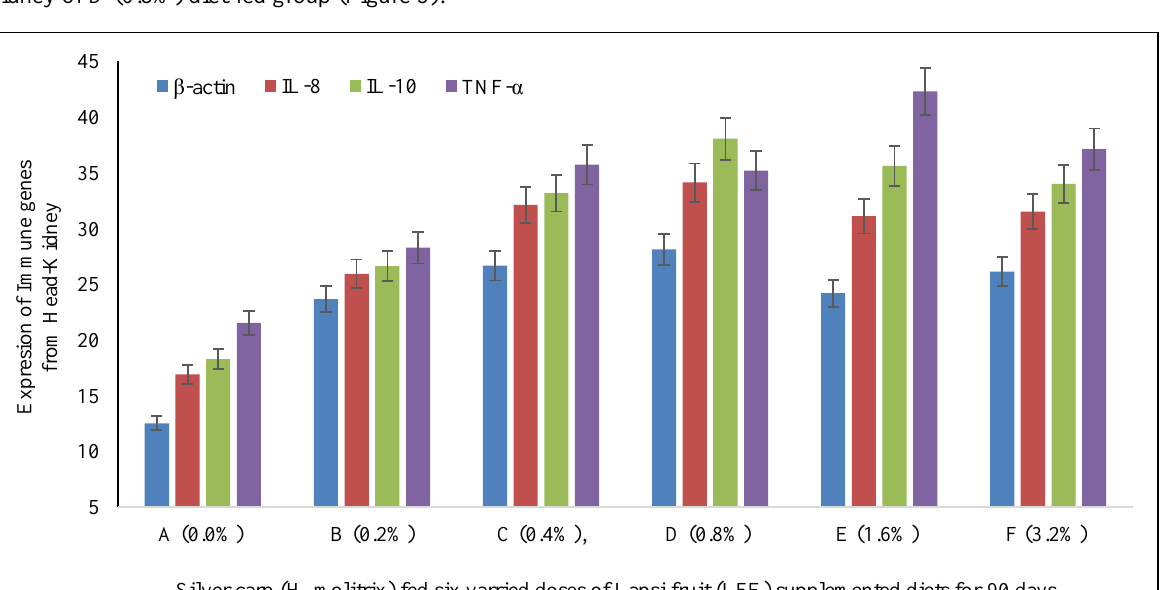
Figure 5. Interleukin (IL-8), Interleukin (IL-10), and Tumor Necrosis Factor (TNF- 𝛼 ) genes relative expression levels to β- actin determined by real-time PCR in the head-kidney of silver carp fed six varied LFE supplemented diets for 90 days. Data represent as means ± standard error (n =